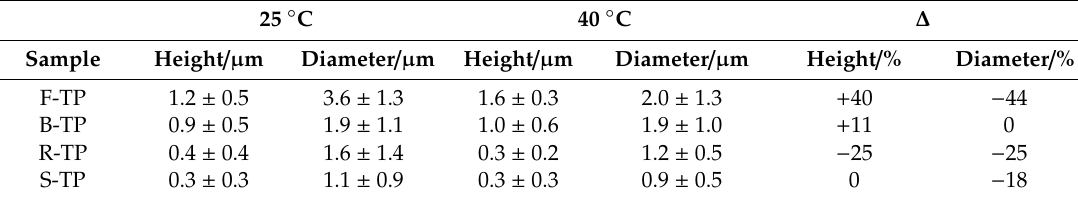
Table 9. Average height and diameter of microcapsules distributed on the paper. 25 ◦ C 40 ◦ C ∆ Sample Height / µ m Diameter / µ m Height / µ